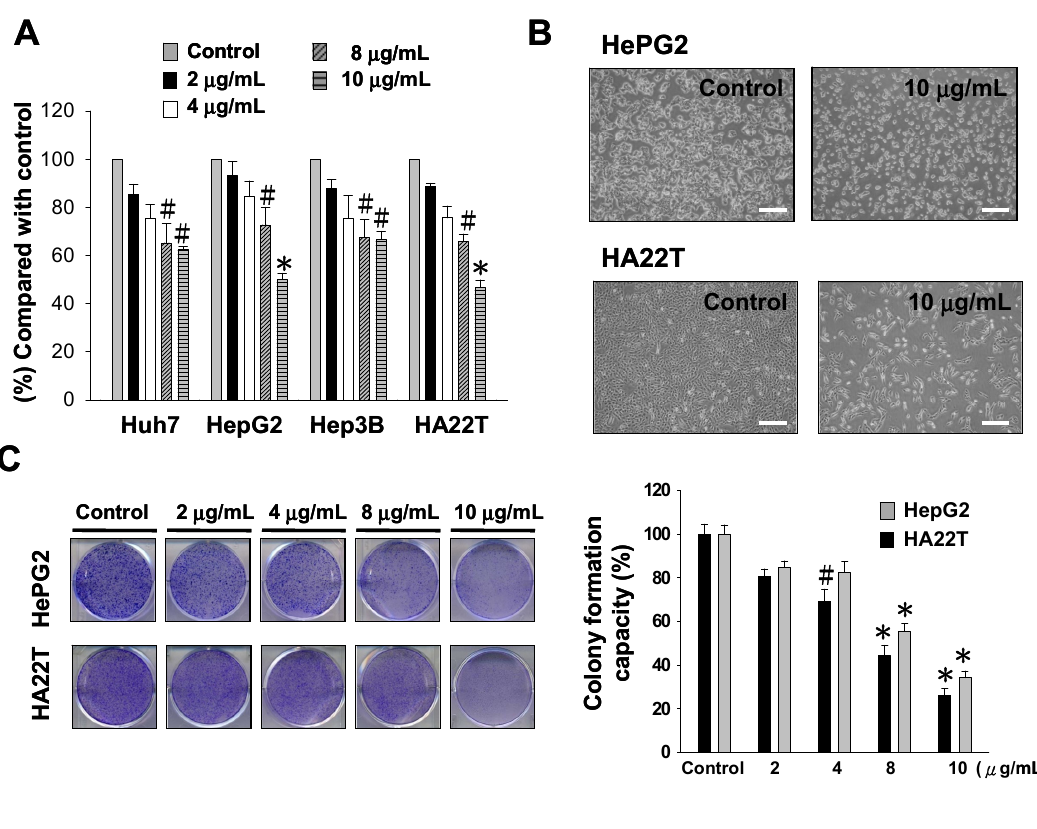
Figure 1. Evaluation of the cell cytotoxicity and colony formation effects of sinulariolide on hepatocellular carcinoma cell lines. ( A ) The viable cell number of different HCC cell lines was dose-dependently suppressed by MTT assay. The results shown are representative of three independent experiments ( # p < 0.05, * p < 0.001 compared with the control). HA22T and HepG2 cell lines were more sensitive to sinulariolide treatment. ( B ) The morphological change of HA22T and HepG2 cells upon sinulariolide treatment. Scale